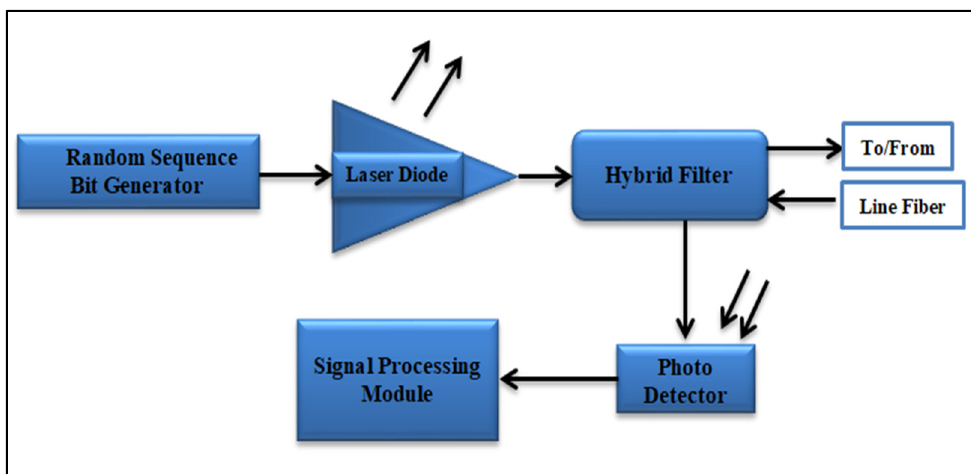
Figure 3. Proposed FPMT detection circuit block daigram.